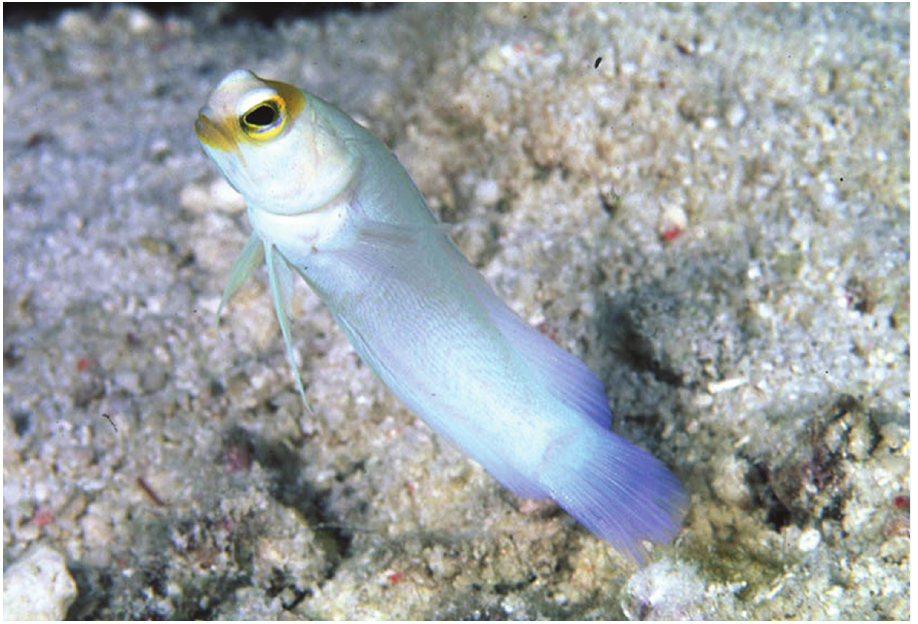
Figure 22. Opistognathus aurifrons , juvenile, Bonaire. Photograph by Scott Michael.